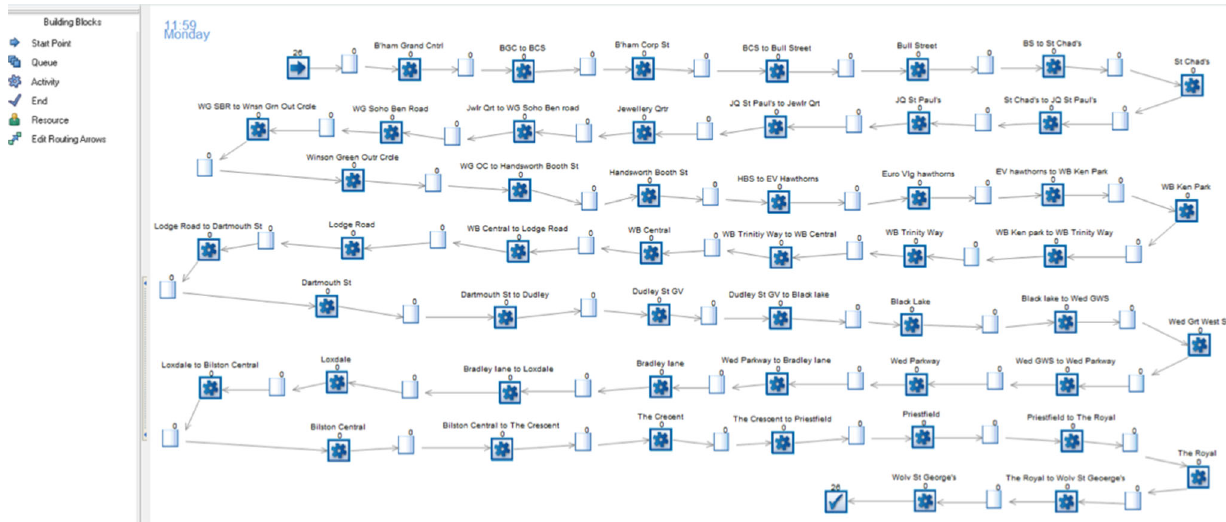
Fig. 4 Simulation layout of Section